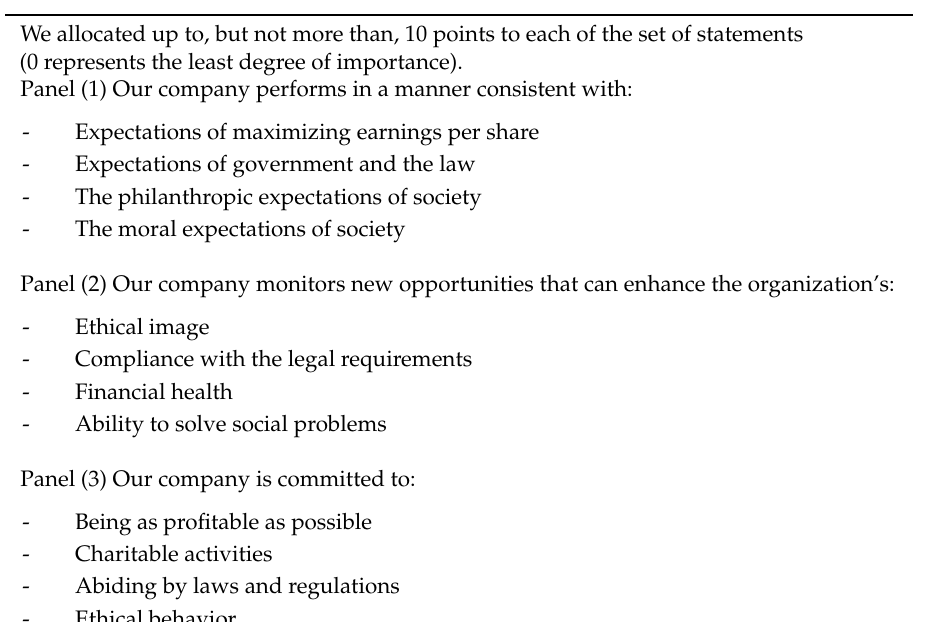
Table 2. This table presents the measurement of the relative importance of financial performance in panel (1), the relative importance of meeting the ethical duty in panel (2) and the altruistic motive behind CSR in panel